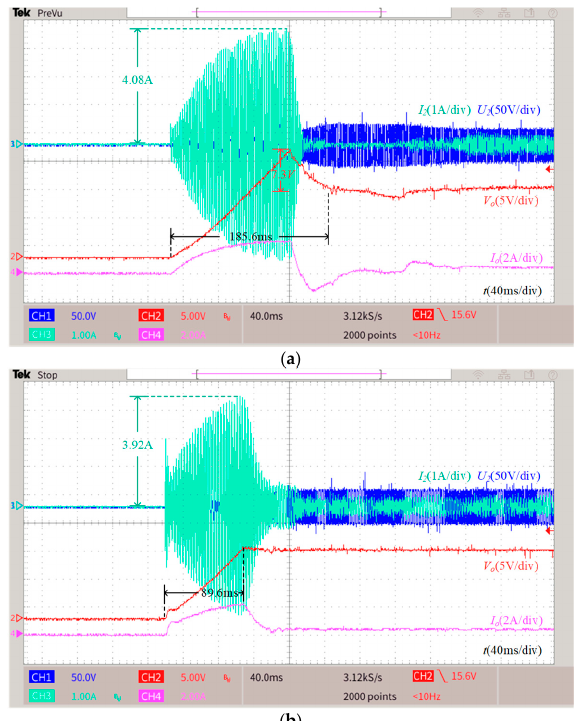
Figure 5. Output voltage tracking error in Case 1 with resistance load, ( a ) PI control, and ( b ) FTSM- ELM control.